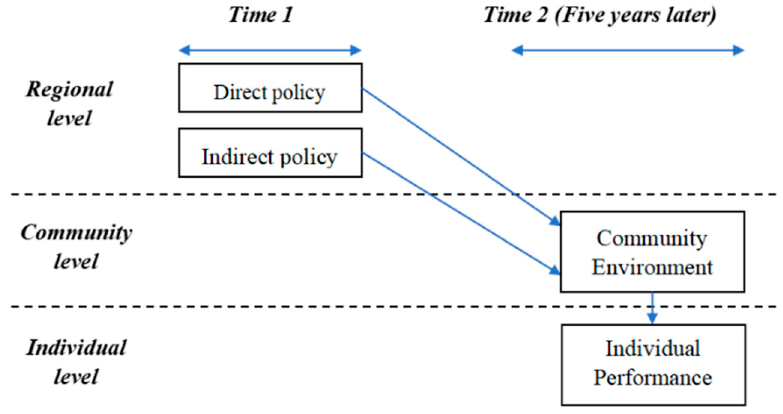
Figure 1. Provincial-level policy interventions to predict individual performance over time.